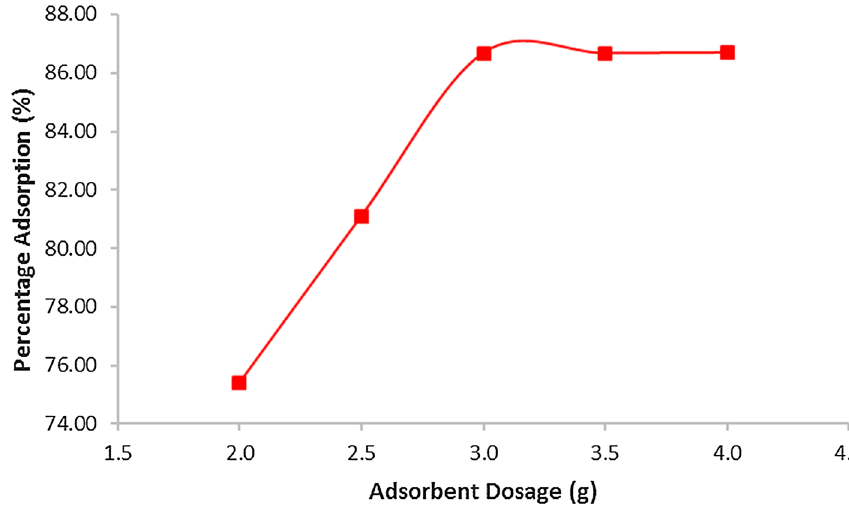
Fig.2 Influence of adsorbent dosage on cyanide adsorption from cassava wastewater onto